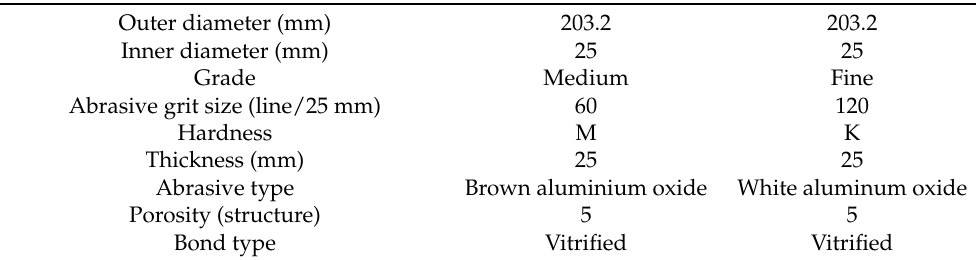
Table 1. Specifications of the aluminium oxide wheels used in this study.